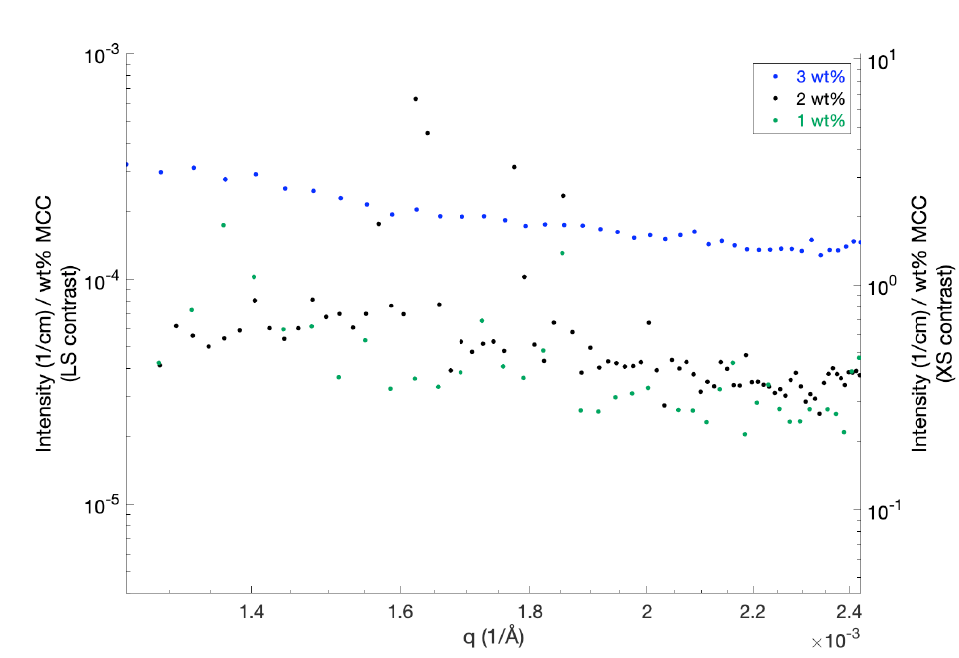
Figure 4. Static light scattering data for MCC dissolved in 8 wt % NaOH for MCC concentrations of 1, 2 and 3 wt %. The scattered intensity is displayed as original light scattering contrast (y-axis, left-hand side) versus scaled to SAXS contrast (y-axis, right-hand side). The intensity was, furthermore, scaled with the respective MCC weight fractions to facilitate comparisons of the different scattering